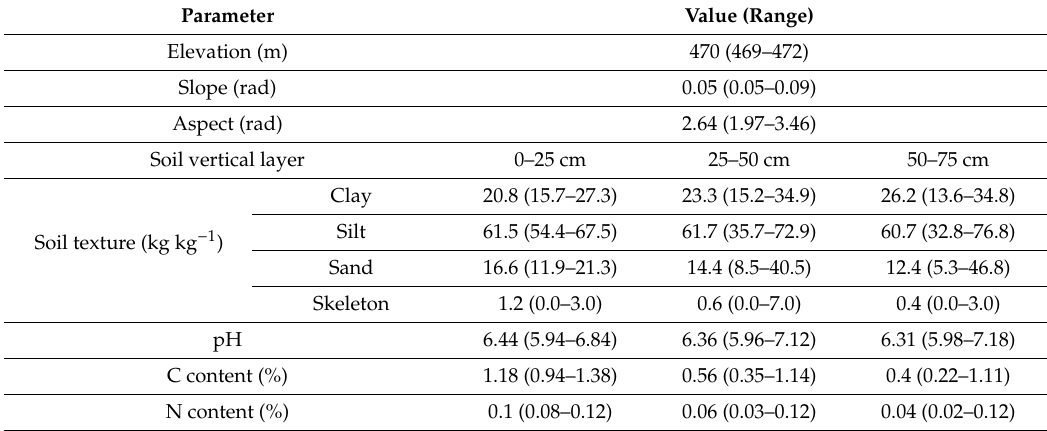
Table 2. Site description of the long-term nitrogen fertilization experiment in Dürnast